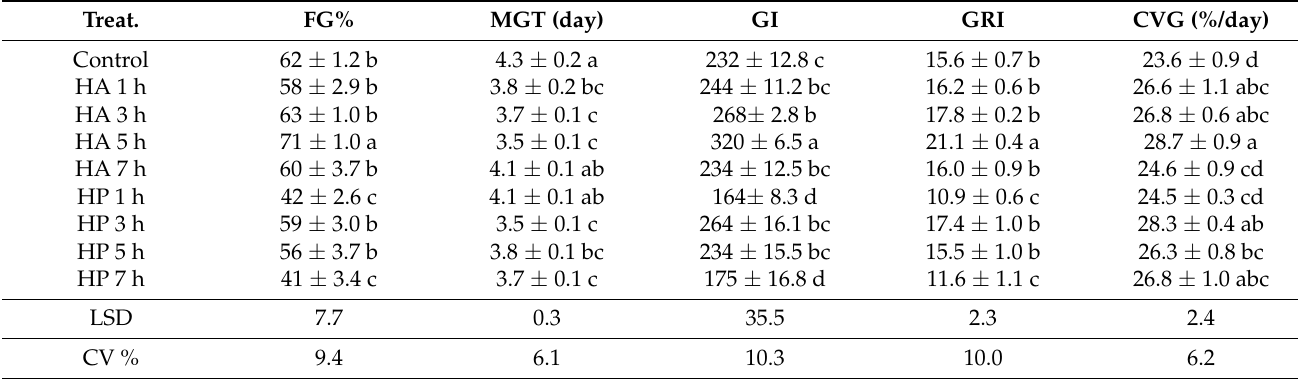
Table 4. Effect of the priming treatments on germination related traits in soybean. Treat.